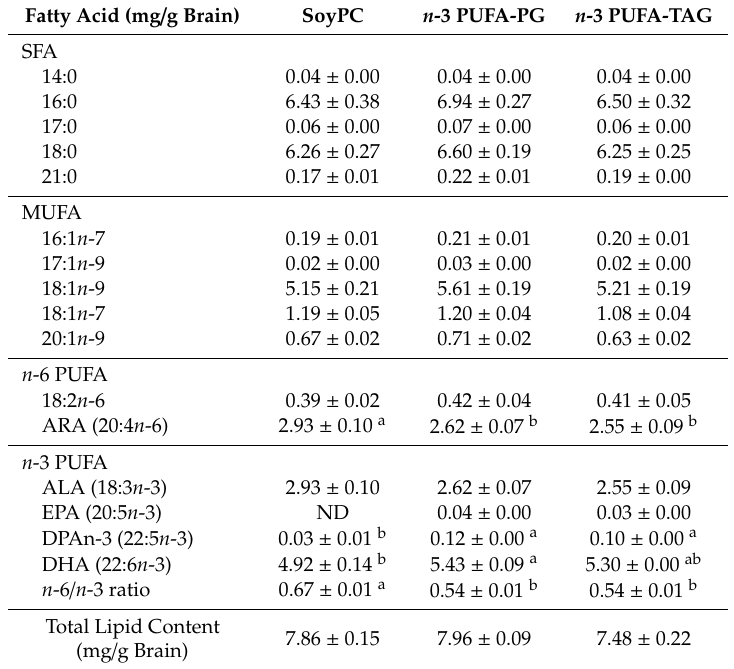
Table 9. Total lipid content and fatty acid composition of the brain in KK- A y mice fed experimental diets. Fatty Acid (mg / g Brain) SoyPC n -3 PUFA-PG n -3 PUFA-TAG